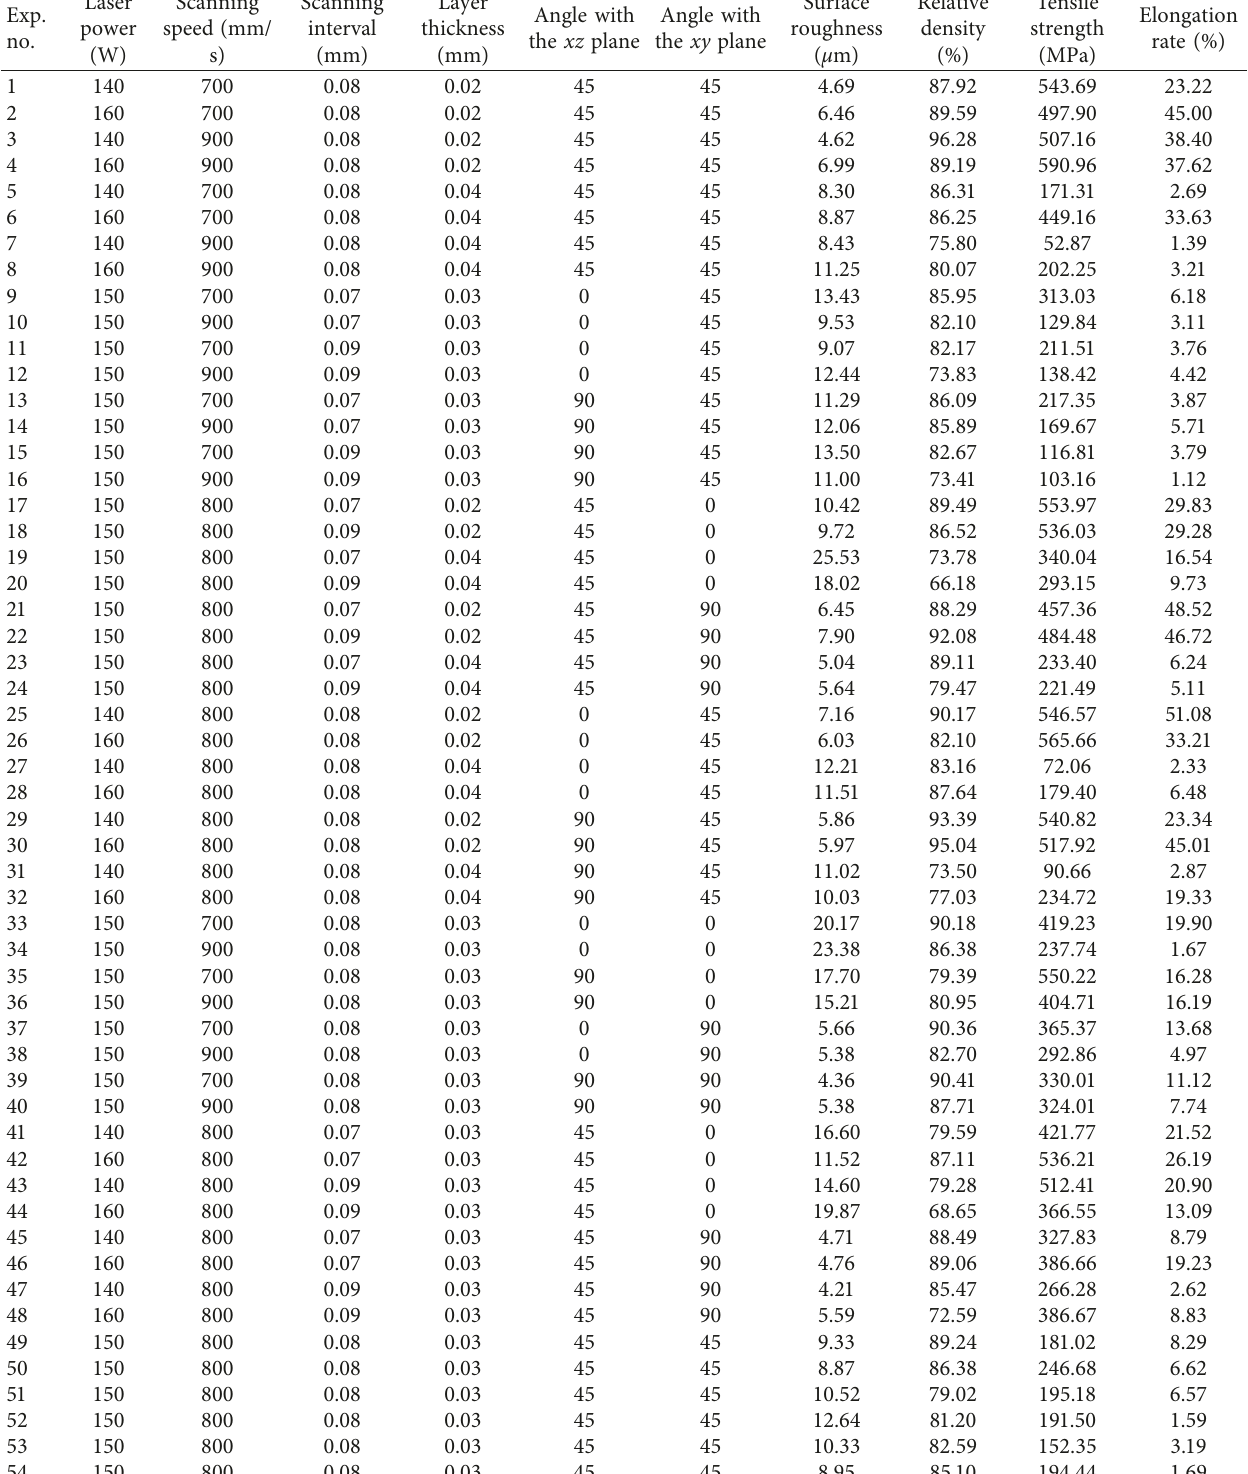
Table 3: Experimental